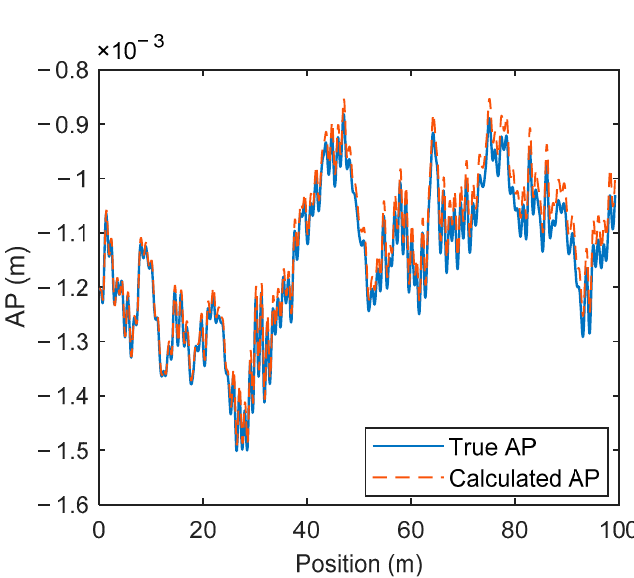
Figure 4. ‘True’ AP and calculated AP using the Inverse Newmark- β equations. Table 1. Vehicle properties used to calculate the AP.